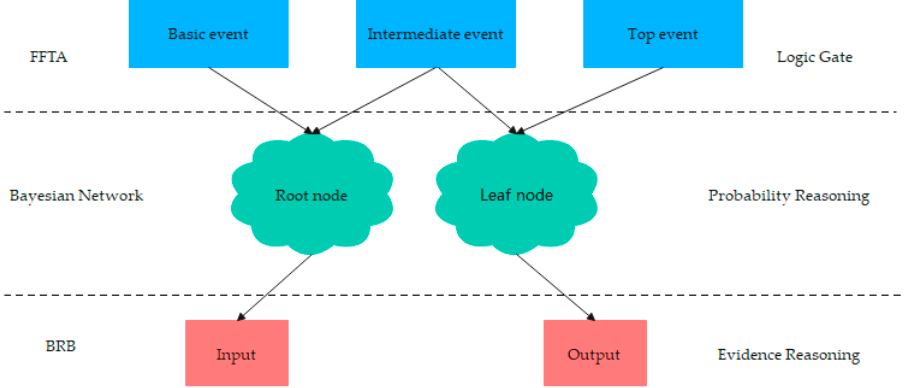
Figure 5. Schematic conversion diagram from FFTA to BRB.